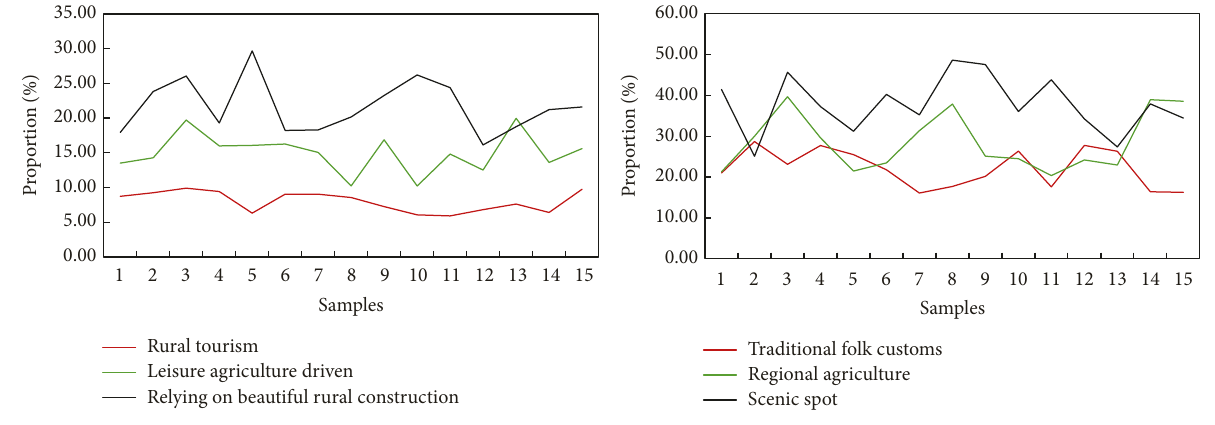
Figure 3: Classification of country house construction in M city. Table 1: Color matching of different stones.